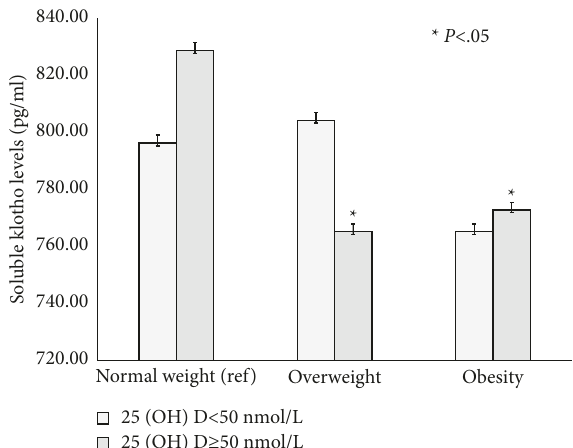
Figure 3: Soluble Klotho levels stratified according to the vitamin D status and BMI